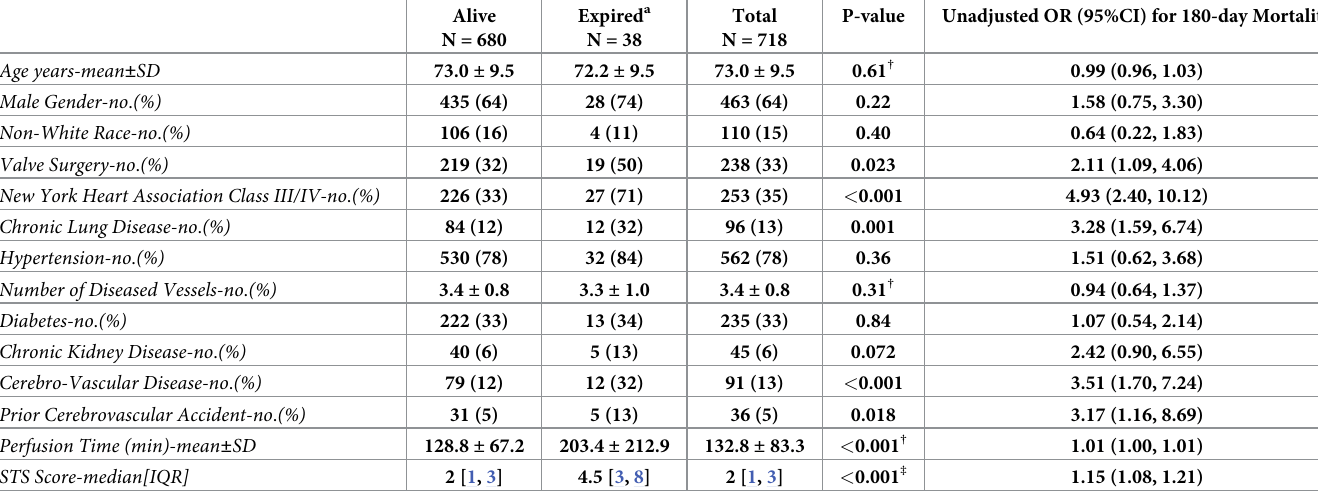
Table 1. Characteristics of the Cohort and Unadjusted Association of Potential Prognostic Determinants with 180-Day Mortality a .